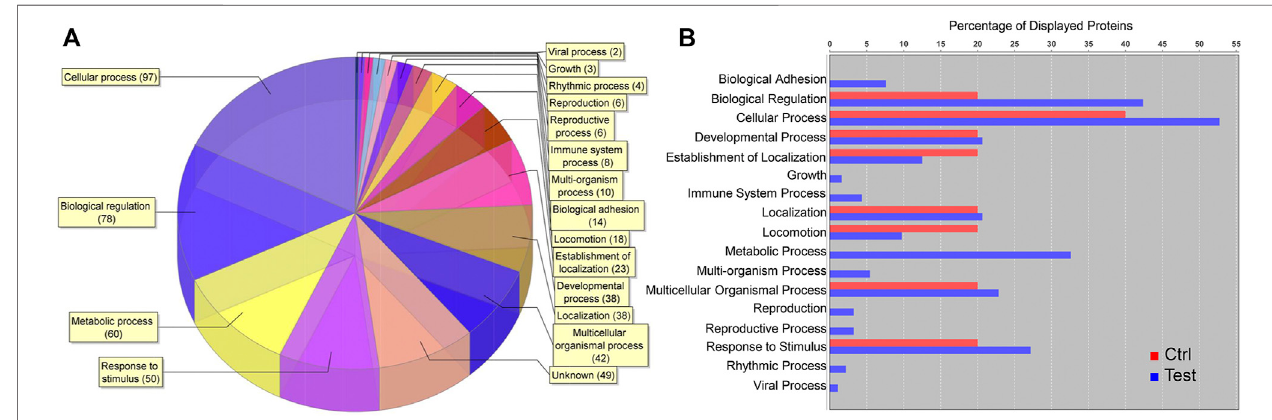
FIGURE9| ProteomicanalysisofcellclustersfrompooledmaleandfemalefelineASCsfollowingcultureinpancreaticdifferentiation(Test)orstromal(Ctrl)medium. A total of 180 proteins were upregulated in the clusters, and the relative distribution among protein GO terms is shown (A) as well as the percentages of each in differentiated (blue) and undifferentiated (red) clusters (B)